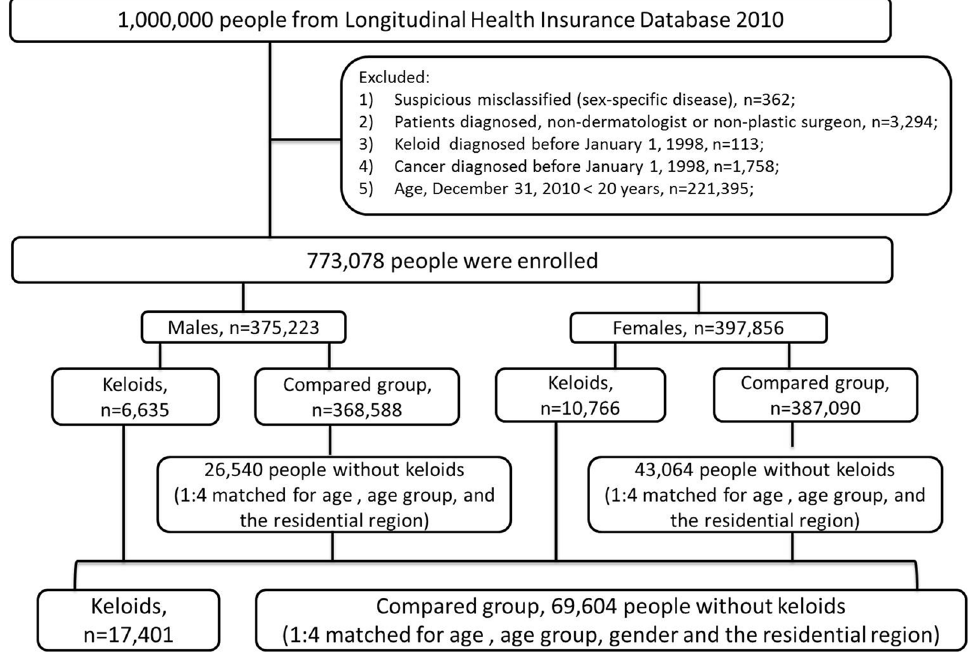
Figure 1. Workflow of the diagnostic process for keloids and cancers using the Longitudinal Health Insurance Database